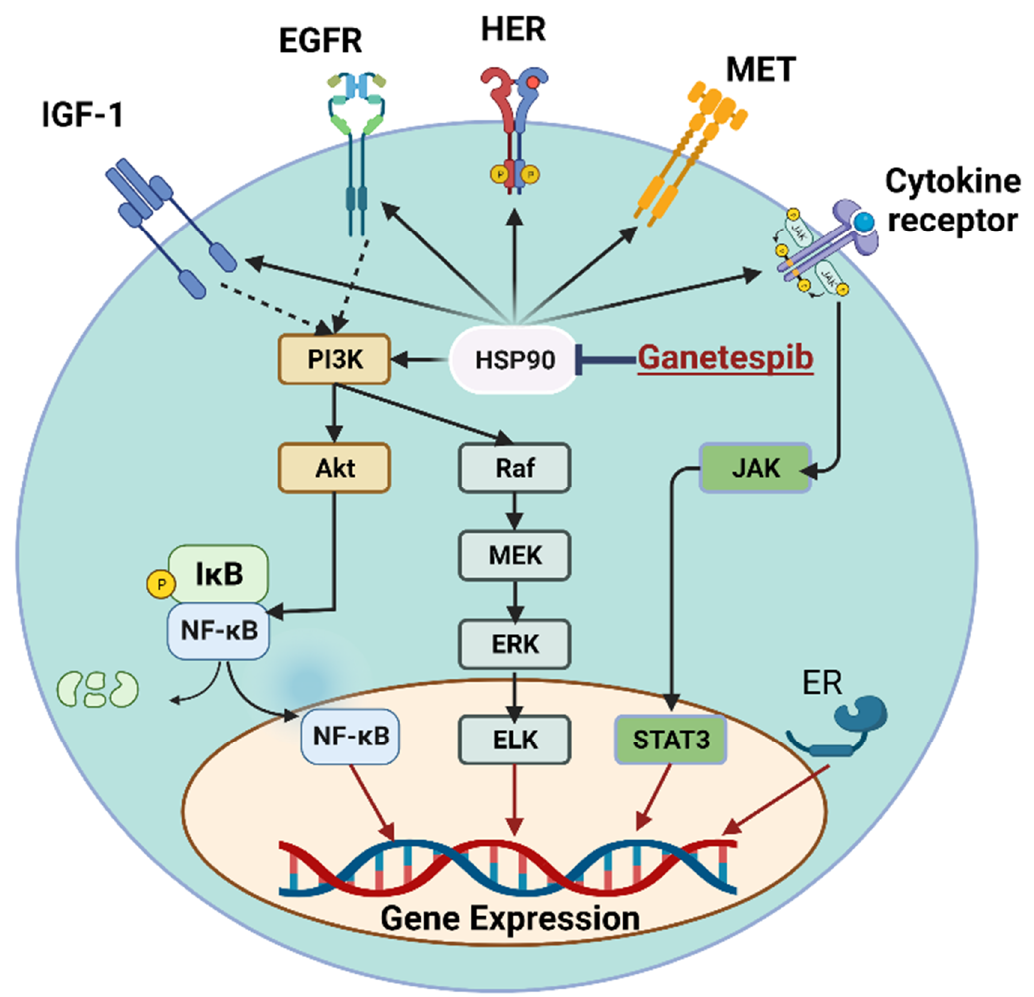
Figure 3. Molecular mechanisms of ganetespib . HSP90 increases the expression of IGF-1 [91,92], EGFR [72], HER [69–71], MET [58,59,80], ER [69], and cytokine receptors. Activation of IGF-1R and EGF stimulates PI3K/Akt/NF-κB and Raf/MEK/ERK signaling, respectively [85]. JAK/STAT3 sig- naling is enhanced by cytokine receptor activation [93]. Ubiquitinated degradation of the inhibitor of NF-κB (IκB), nuclear translocation of NF-κB, ERK, and STAT3 stimulate gene expression of mediators that increase tumorigenesis. Ganetespib-mediated inhibition of HSP90 leads to the suppression of these signaling mechanisms and anticancer effects.